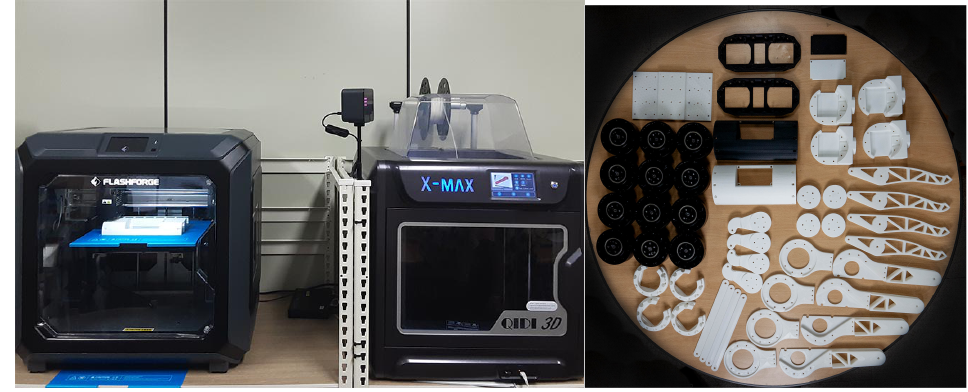
Figure 10. 3D printing of structural